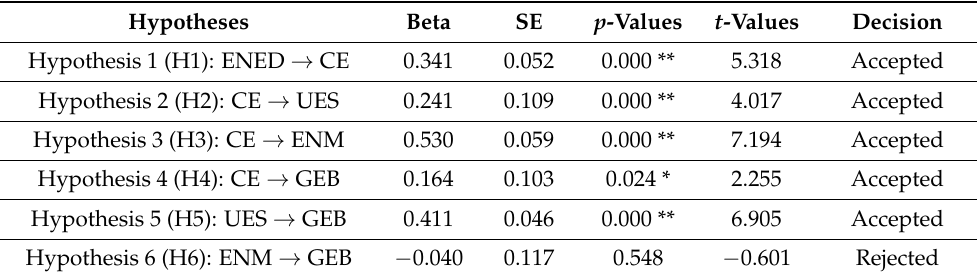
Table 3. Hypotheses assessment